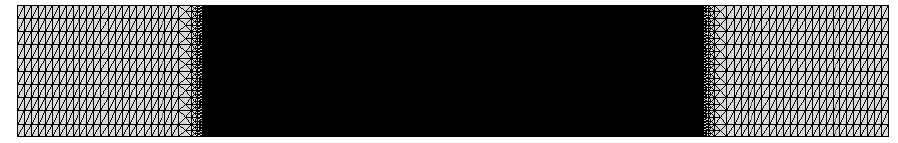
Figure 4. FE mesh of analyzed beam LM200.